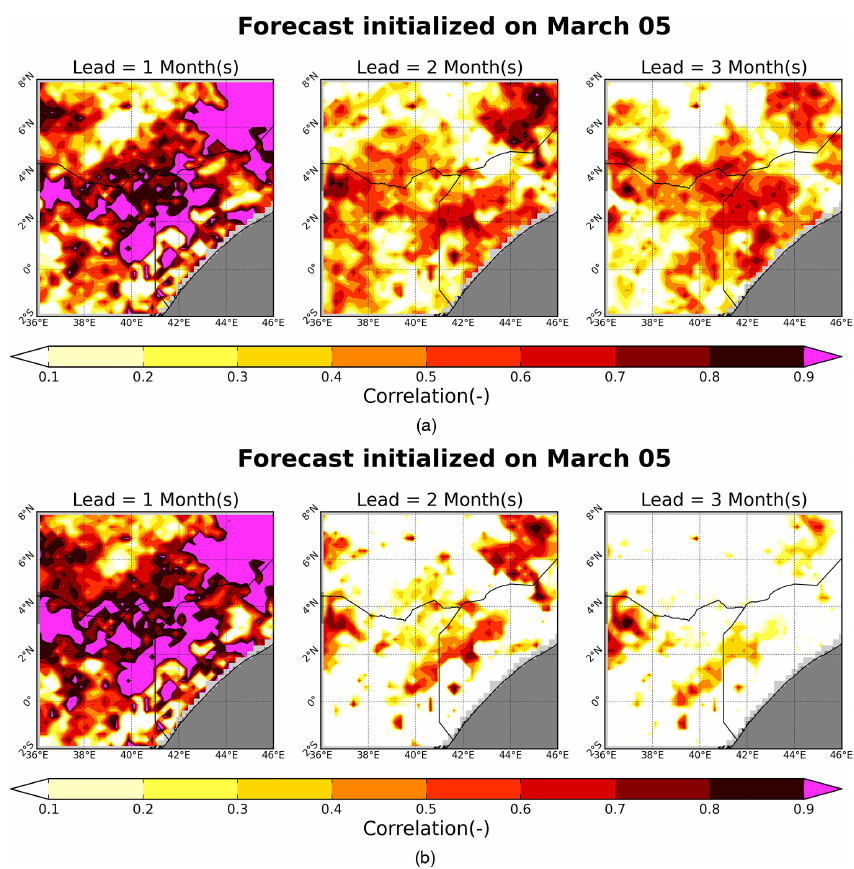
Figure 8. Skill of soil moisture forecasts (i.e., correlation between ensemble median of soil moisture forecasts and a posteriori estimates) initialized on 4 March (start of the season) estimated using (a) CFSv2-based seasonal climate scenarios and (b) ESP